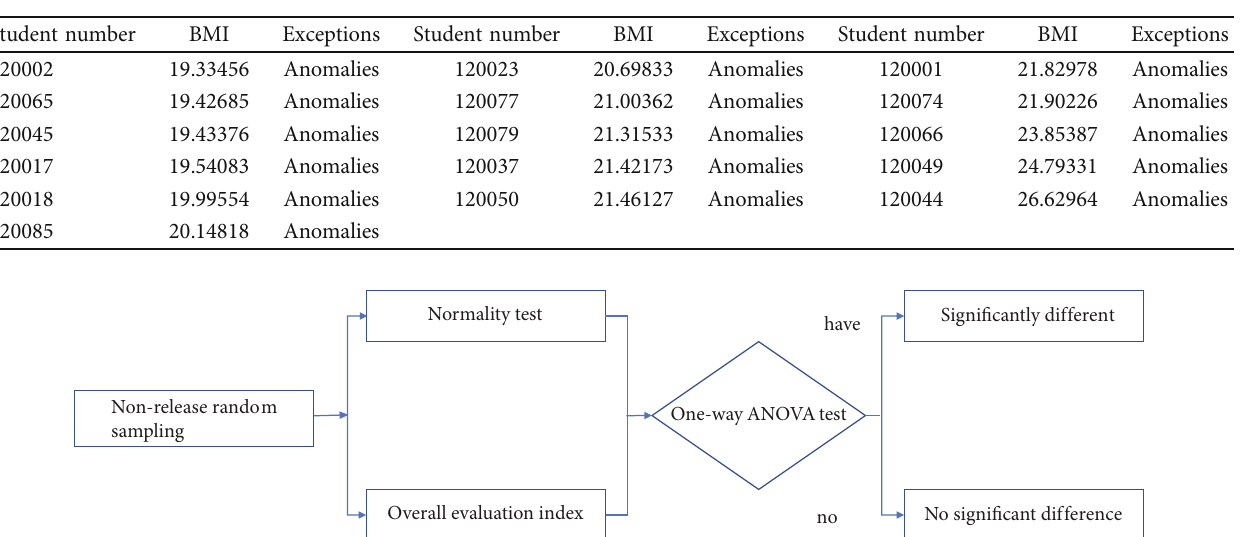
Table 4: Signi fi cant deviations in student test data.